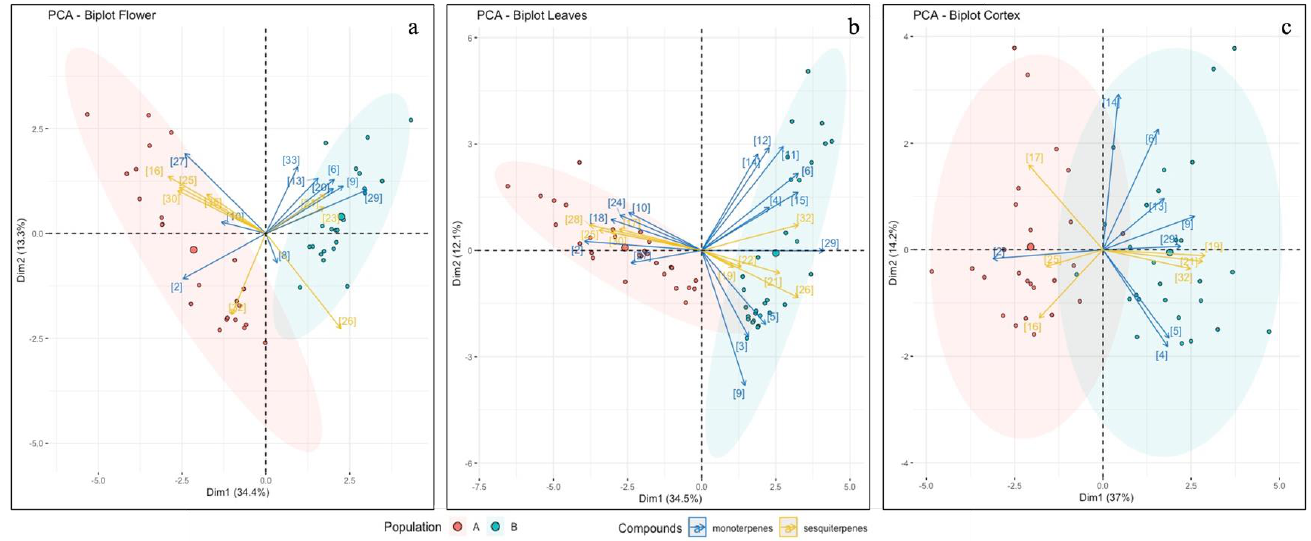
Figure 6. Principal component graph of monoterpenes and sesquiterpenes in flowers ( a ), leaves ( b ) and bark tissues ( c ) based on the first two principal components. Number on arrows represents compounds: (2) α -pinene; (3) α -fenchene; (4) camphene; (5) β -pinene; (6) myrcene; (8) α -terpinene; (9) limonene; (10) 1,8-cineole; (11) (E)- β -ocimene; (12) (Z)- β -ocimene; (13) γ -terpinene; (14) p-cymene; (15) terpinolene; (16) α -ylangene; (17) α -copaene; (18) α -thujone; (19) isoitalicene; (20) linalool; (21) italicene; (22) (Z)- α -bergamotene; (23) (E)- α -bergamotene; (24) terpinel-4-ol; (25) β -cariophillene; (26) β -himachalene; (27) α -terpineol; (28) Sesqui6_UNK; (29) neryl-acetate; (30) δ -cadinene; (32) α -curcumene; (33) nerol; (35) rosifoliol. H. litoreum is reported in population A, and H. italicum subsp. italicum in population